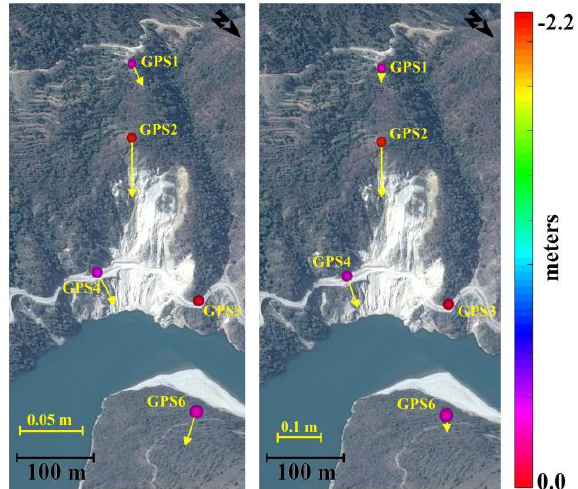
Figure 4. GNSS horizontal and vertical displacement estimates between epochs (a) 1-2 and (b)1-3 for the Sirobagarh site. Black scale bar denotes the image scale, whereas the yellow coloured shows scale for the horizontal displacement vectors. Yellow arrows show horizontal movement and the color of the dots show vertical